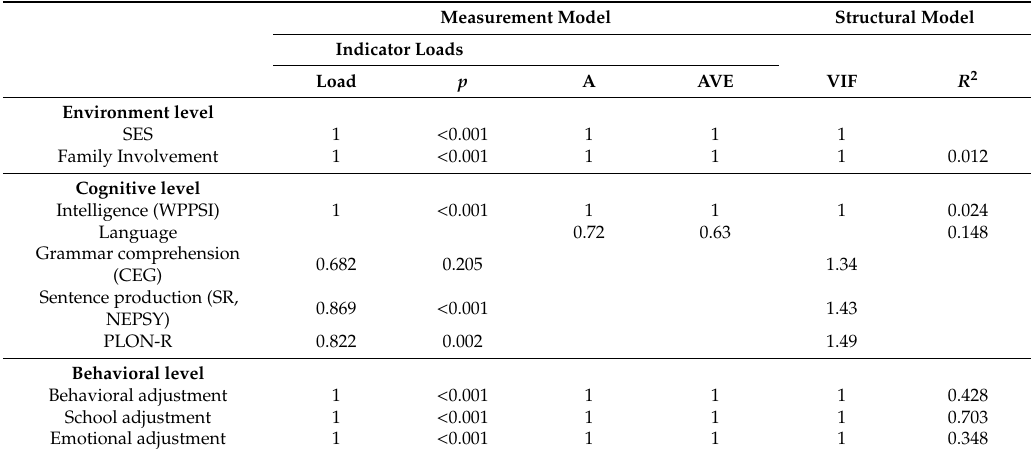
Table 3. Measurement and structural model statistics of the study